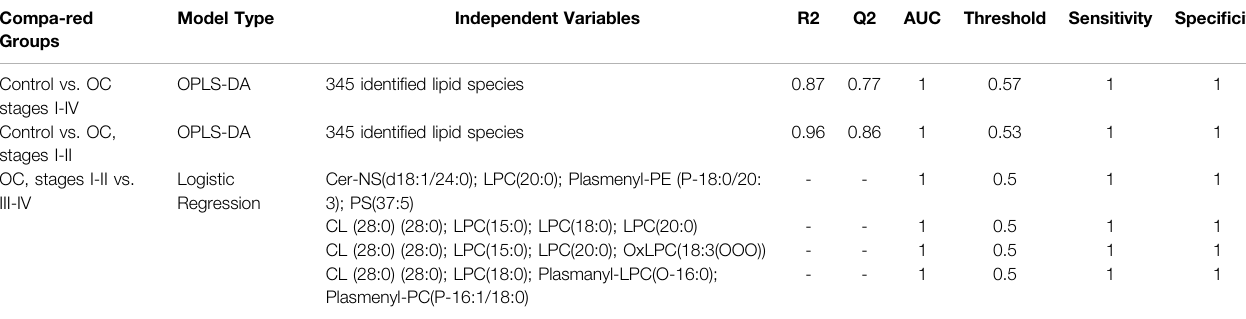
TABLE 2 | Parameters of the developed